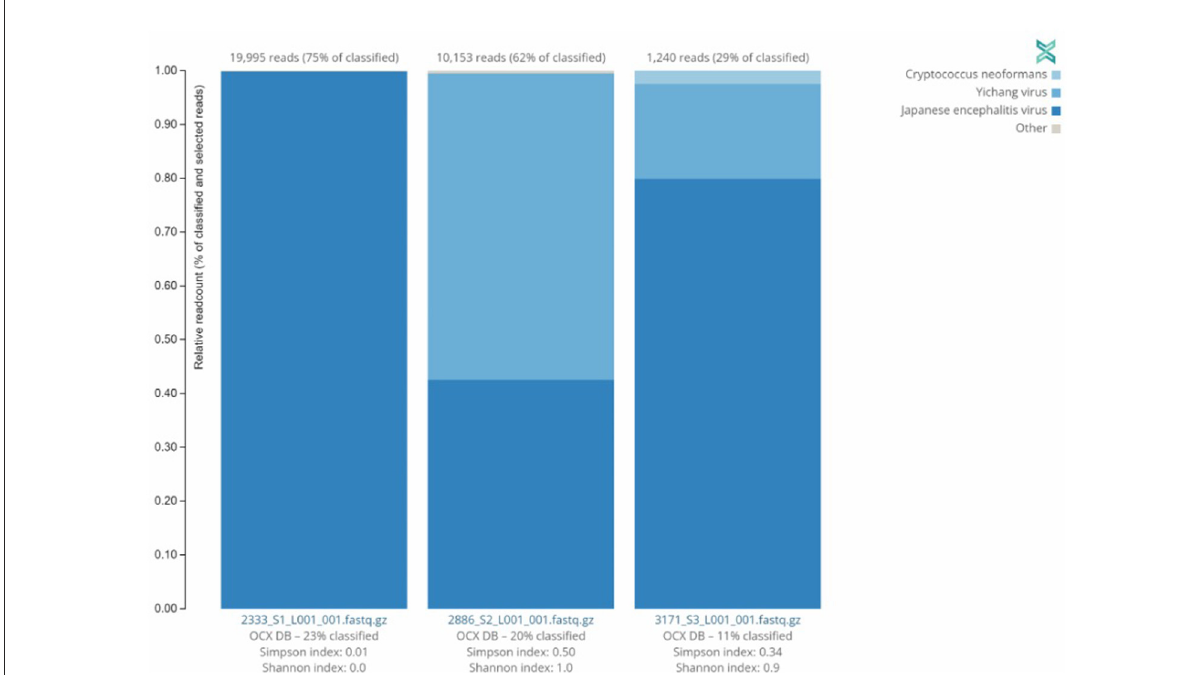
FIGURE2 Distribution of sequences identified by Twist CVRP. Three of the JEV positive samples analyzed with the Twist Biosciences CVRP are shown with their read counts and individual distributions of Japanese encephalitis virus, Yichang virus, Cryptococcus neoformans , and other sequences.